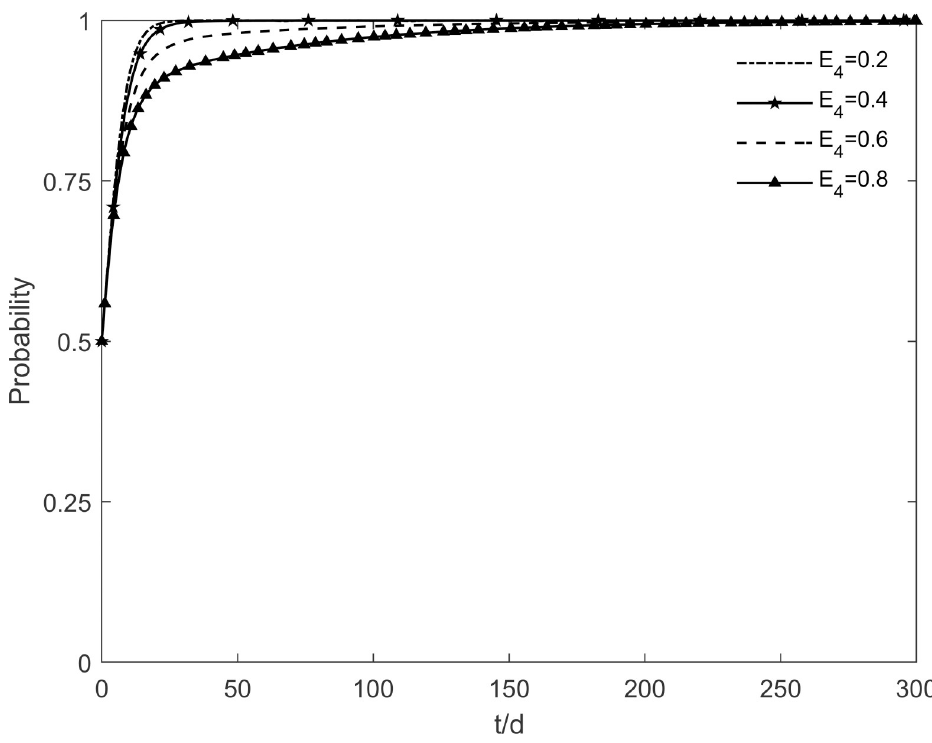
Fig 21. The impact of E 4 on the government’s strategic